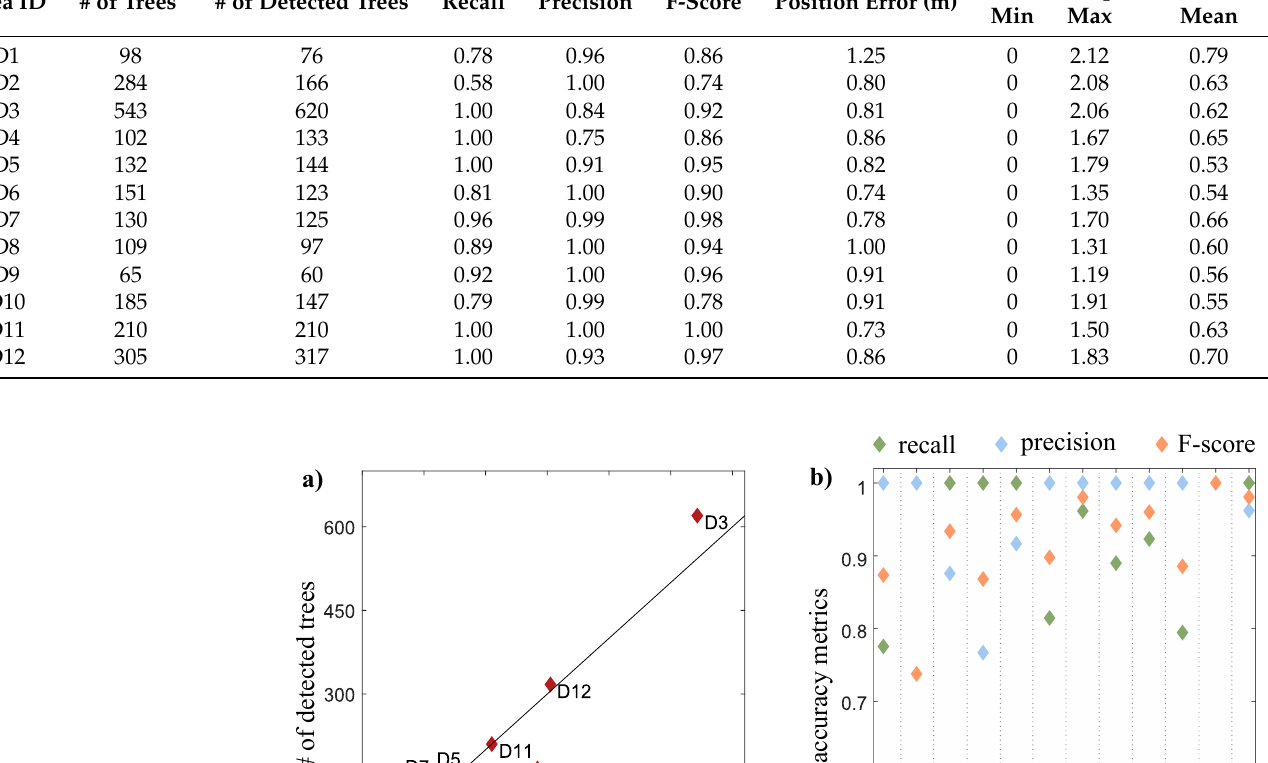
Table 2. Comparison between the count of actual trees and the count of the trees detected by the algorithm, the accuracy metrics, the position error, and the main statistics of the stem-to-top distance for each study area. Area ID